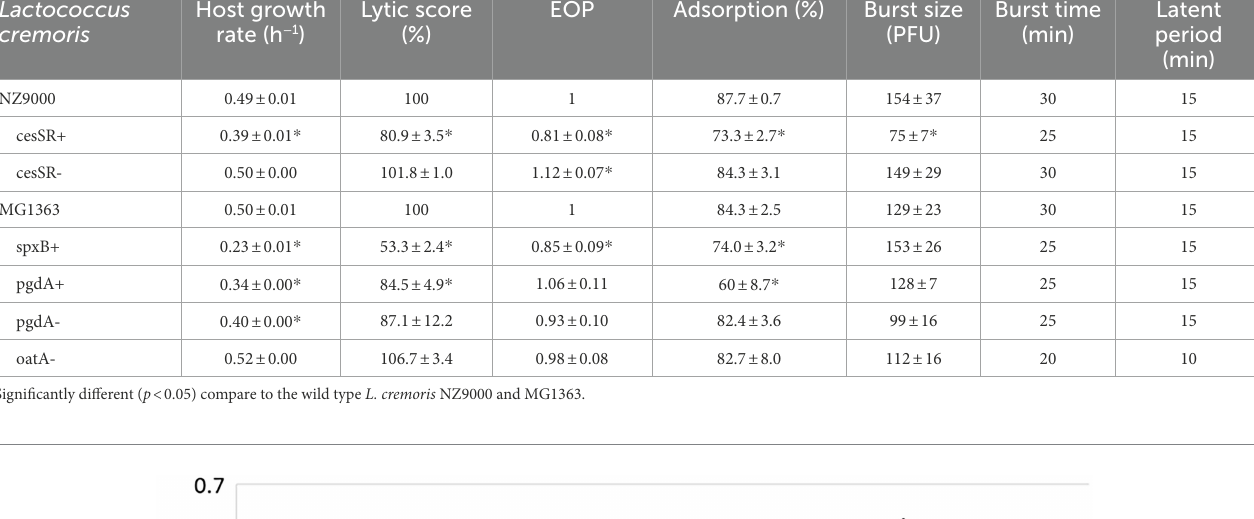
TABLE 3 Phage c2 growth parameters during infection of lactococcal CES and PG mutants. Lactococcus cremoris